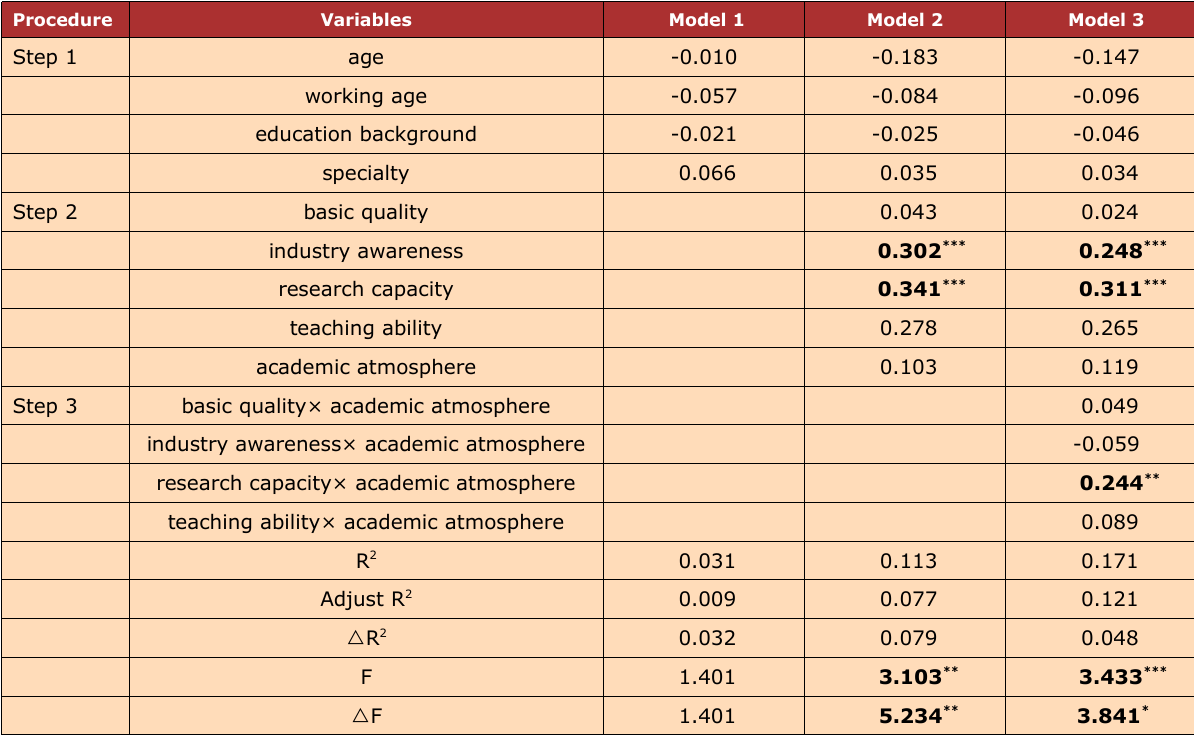
Table 3. Regulating role of academic atmosphere in the interaction between the competency and job